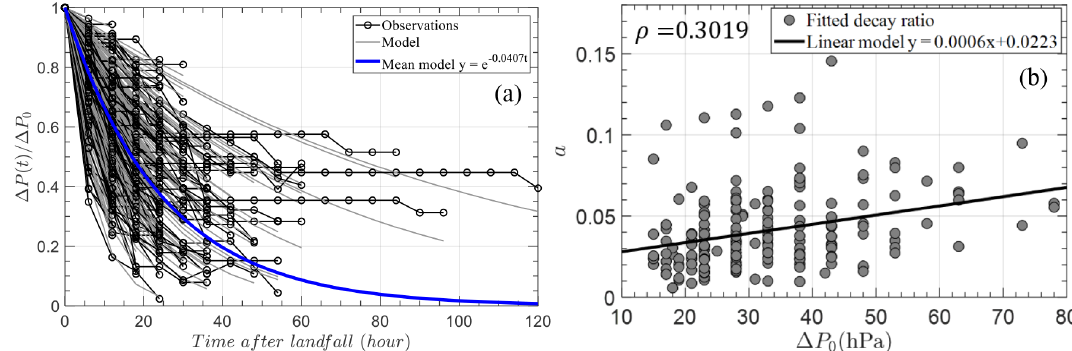
Figure 12. Decay model in circular subregion around Hong Kong: (a) curve fitting of decay model; (b) decay rate versus (cid:49)P 0 .